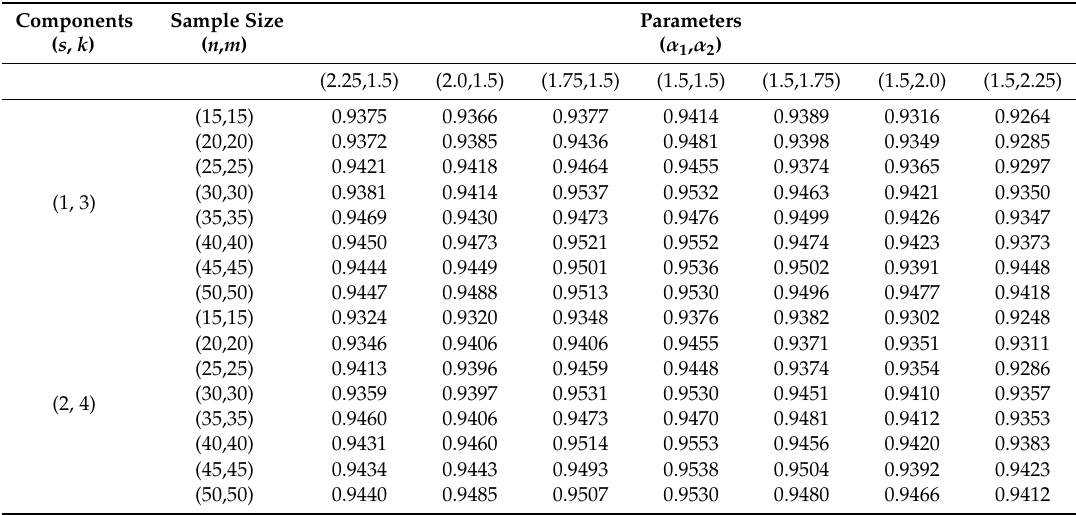
Table 4. Coverage probability of the simulated 95% confidence interval of reliability R s , k